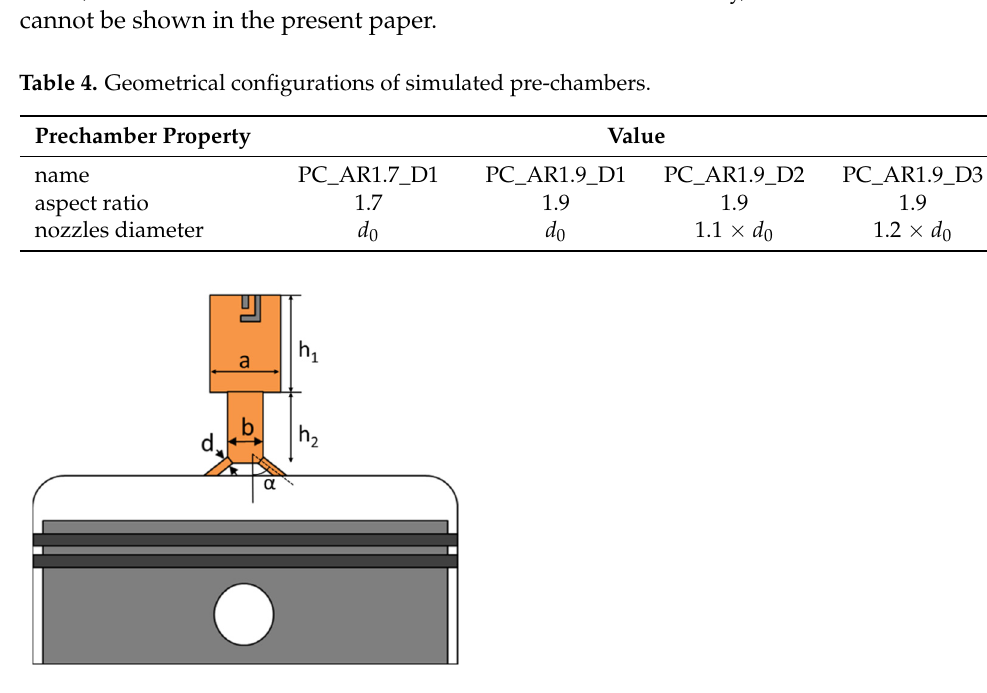
Figure 4. Schematic of the main geometrical features of the